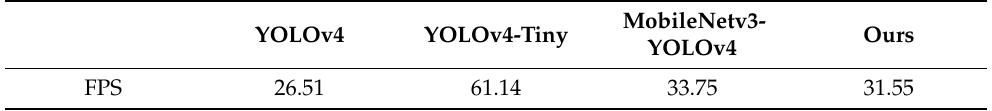
Table 10. Detection